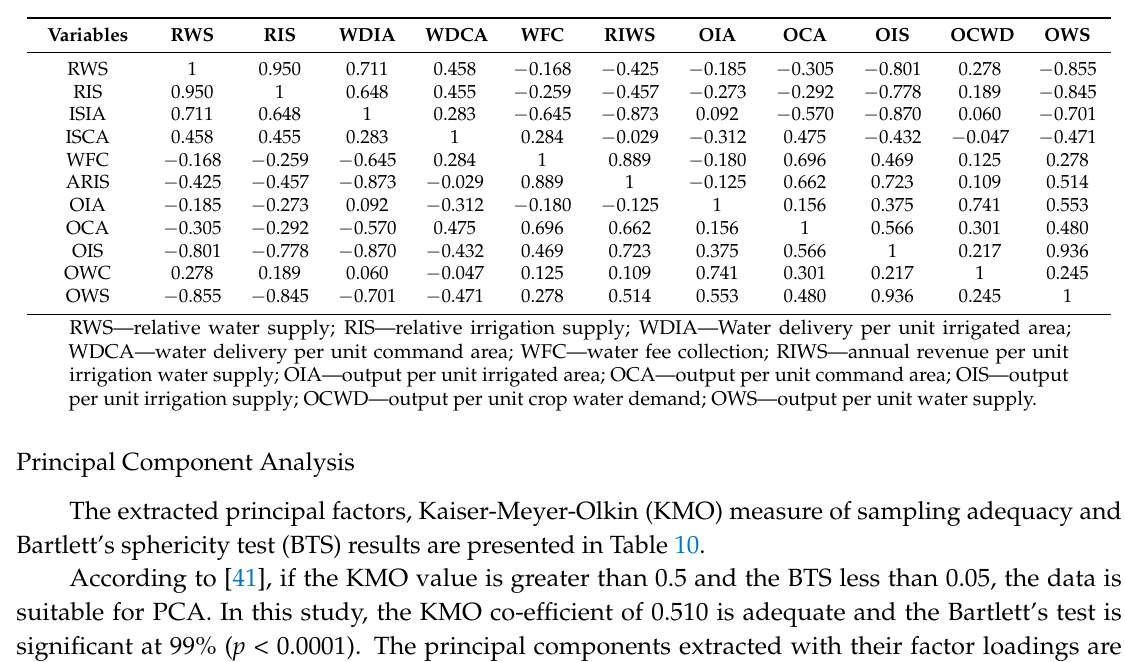
Table 9. Pearson correlation matrix ( n